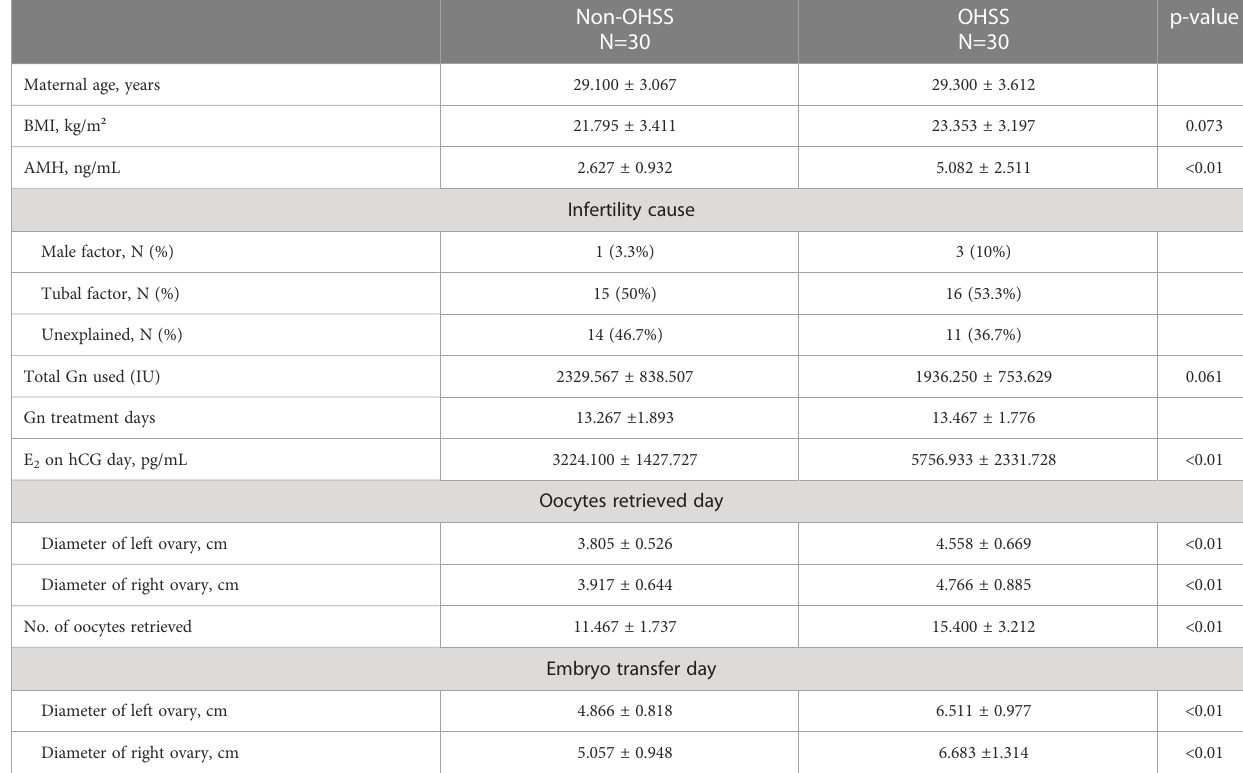
TABLE 1 Clinical information for OHSS patients and the control